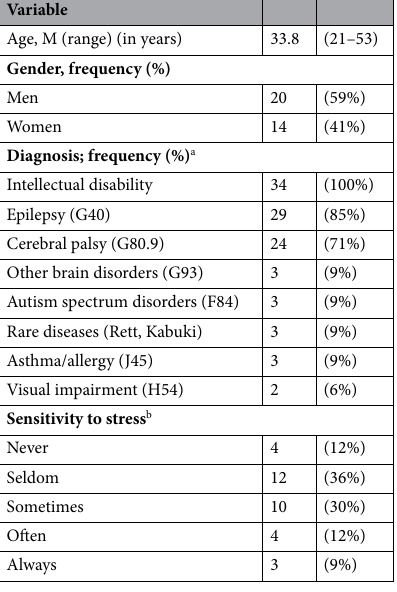
Table 1. Characteristics of the study participants. Most participants have more than one diagnosis; thus, the sum of percentage is larger than 100. a ICD-10 code in parenthesis. b Missing values on one participant.